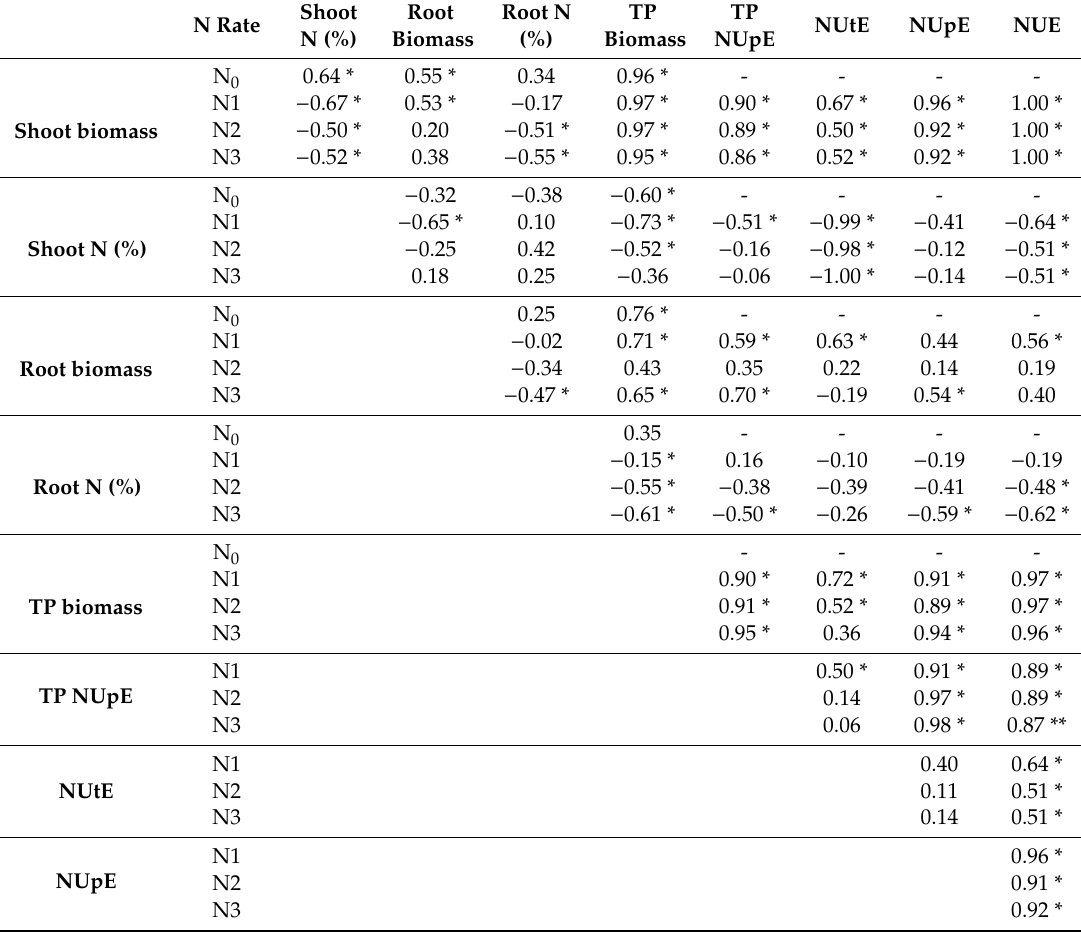
Table 3. Pearson’s correlation among shoot, root, and TP variables related to nitrogen use e ffi ciencies of six wheat lines grown under four di ff erent N rates in hoop